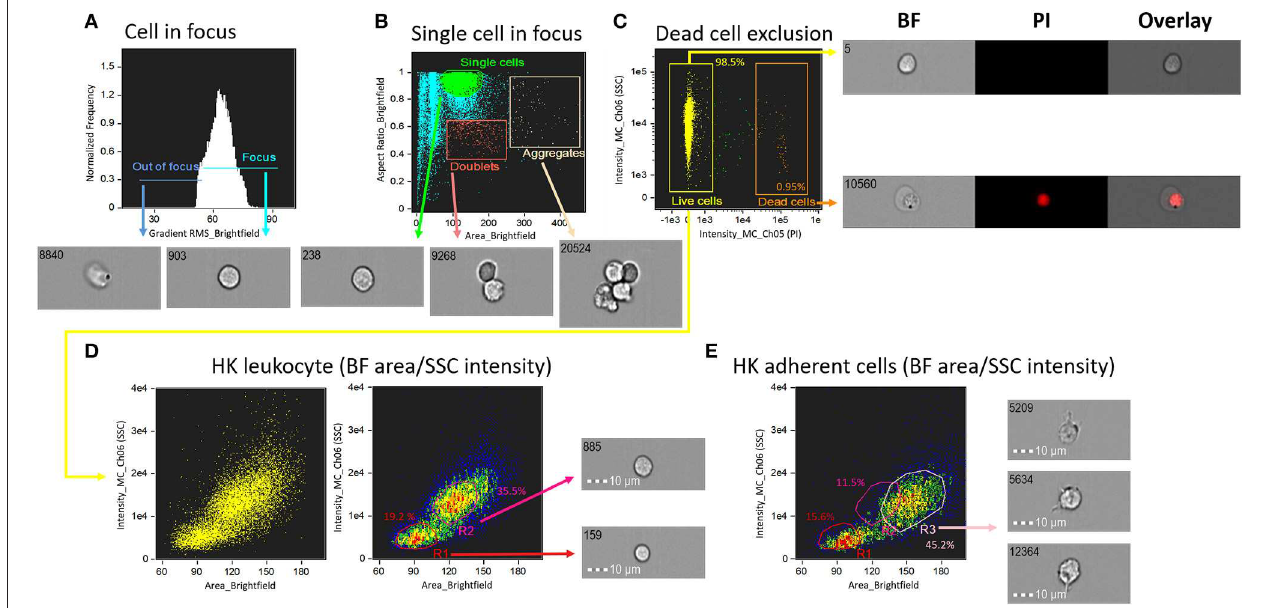
FIGURE 1 | Schematic of the gating strategy to determine areas and populations of head kidney cells from Atlantic salmon. (A) Focused cells were gated using IDEAS ® gradient RMS feature which helps to select high-quality images with RMS values above 50. (B) Representative image showing the gated cells; single cells, doublets and aggregates are shown in a dot plot. Aspect ratio is a feature that evaluates an elliptical shape fitted around the detected object. The ratio is calculated as the minor axis divided by the major axis; a value close to 1 indicates that the cell has a circular shape, while a value in the range 0.4–0.8 signals the presence of doublets or aggregates if the individual cells are of oval morphology. (C) Orange dots are the dead cells that were excluded using propidium iodide, to separate the live cells (yellow dots). (D) HK leukocyte population is shown in a brightfield (BF) area (cell size) vs. side scatter (SSC) intensity (cell internal complexity) plot. (E) HK adherent cell (macrophage-like cell) population is shown in a BF area vs. SSC intensity plot. All cell images were captured with 40 × objective. Scale bar = 10 µ m. BF, brightfield; PI, propidium iodide; R, region; R1, lymphocyte-like cells; R2, monocytes/macrophages-like cells; R3, macrophage-like